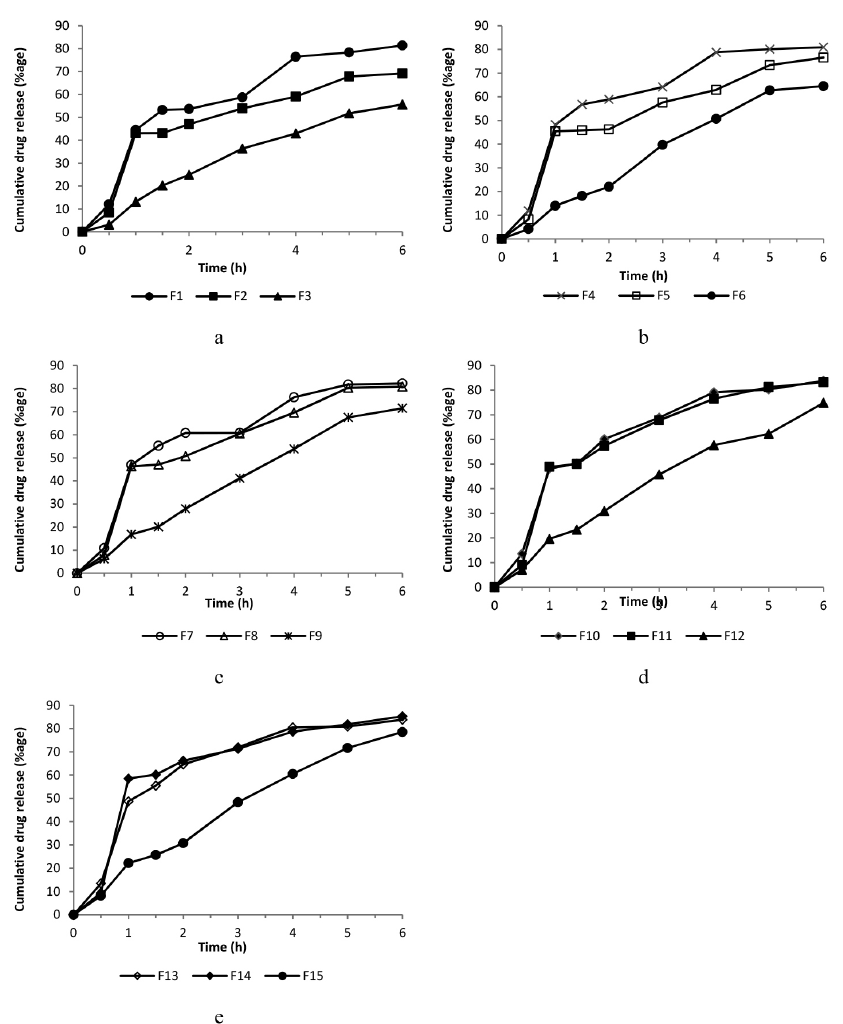
FIGURE 1 - Drug release profile of different theophylline microcapsule formulations a) F1-F3 (no plasticizer) b) F4-F6 (10% plasticizer), c) F7-F9 (20% plasticizer), d) F10-F12 (30% plasticizer) e) F13-F15 (40%